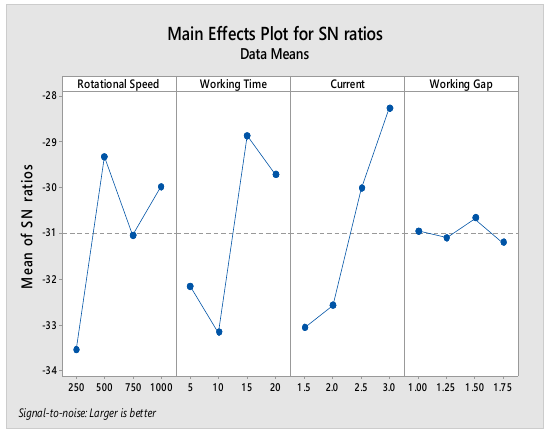
Fig. 3. The S/N ratio effect on the parameters of stainless steel 304 on the MRR.